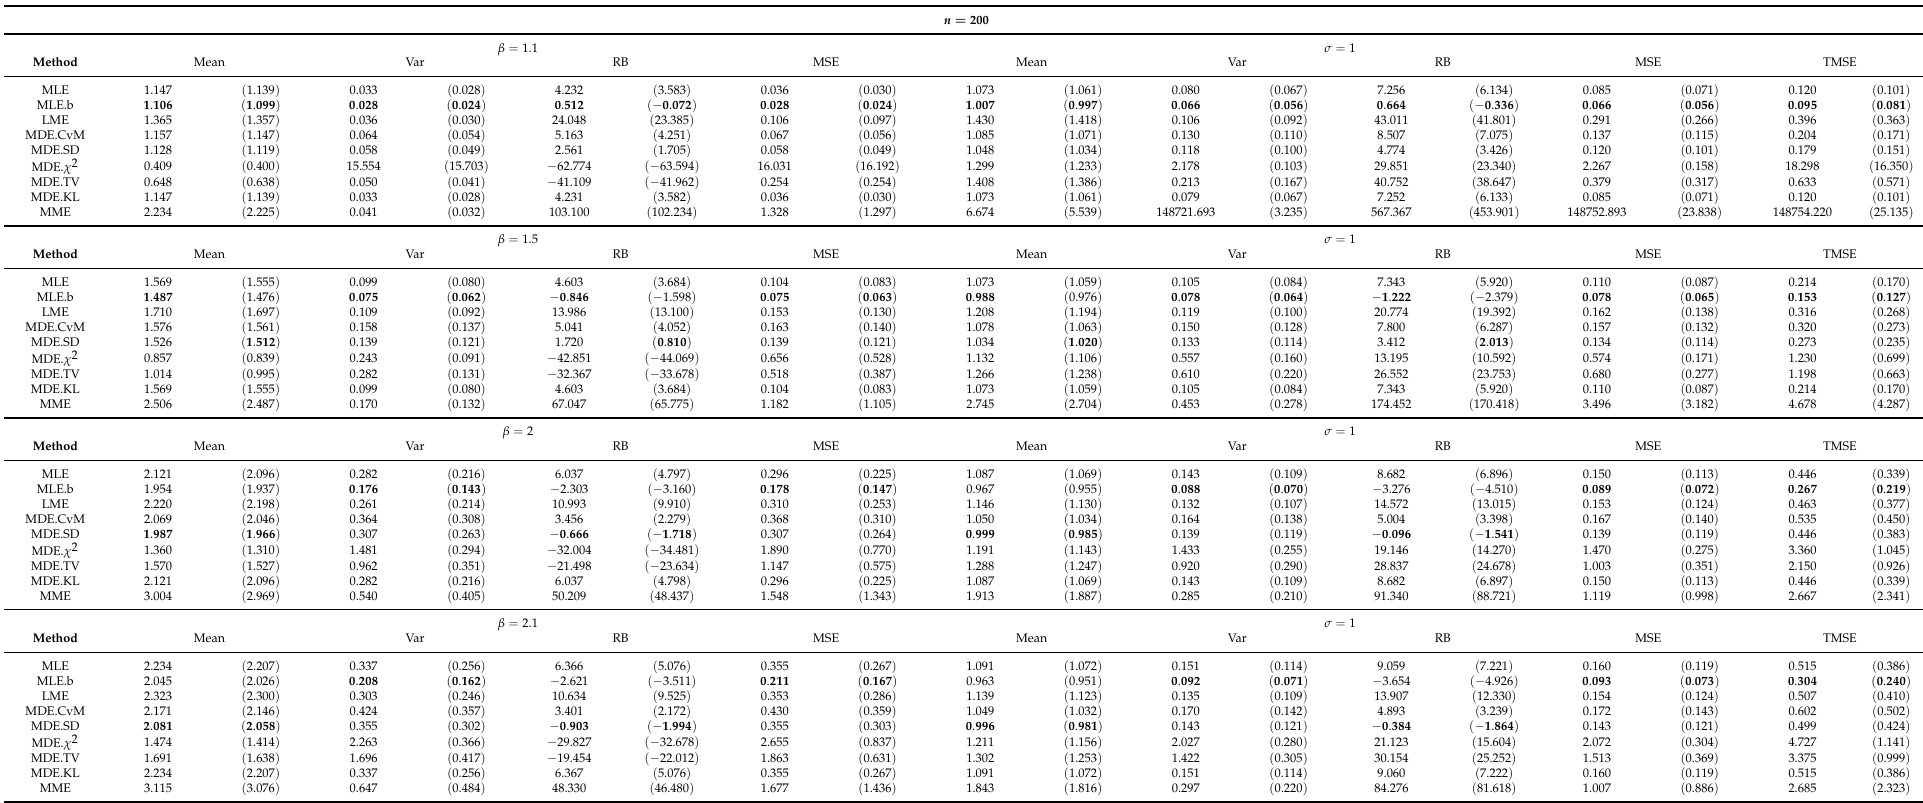
Table A3. Comparison of different estimation methods for different values of β ( σ = 1 and n =